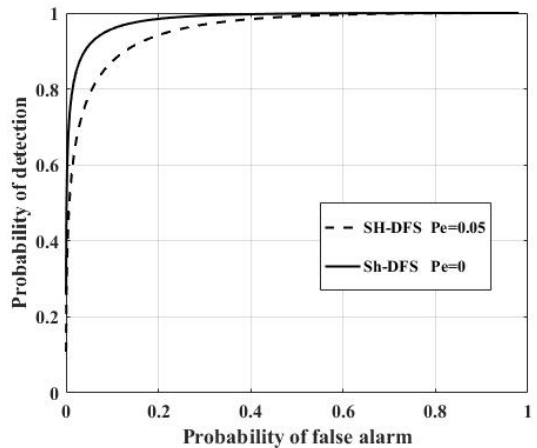
Figure 17. The probability of detection of the clustered distributed system with SH-DFS with P e = 0 and P e = 0.05 versus the global desired probability of false alarm at the FC.